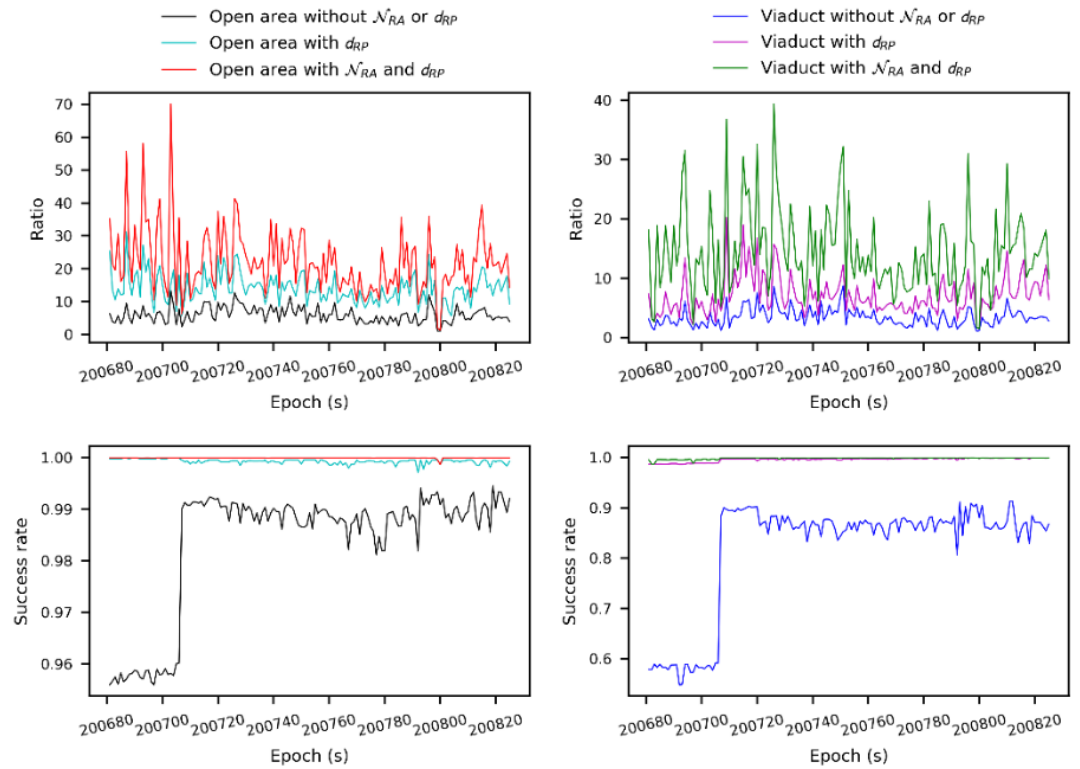
Figure 9. Time series of ratio values, success rate and the number of common nonreference satellites between the two vehicles in absolute positioning for six cases.